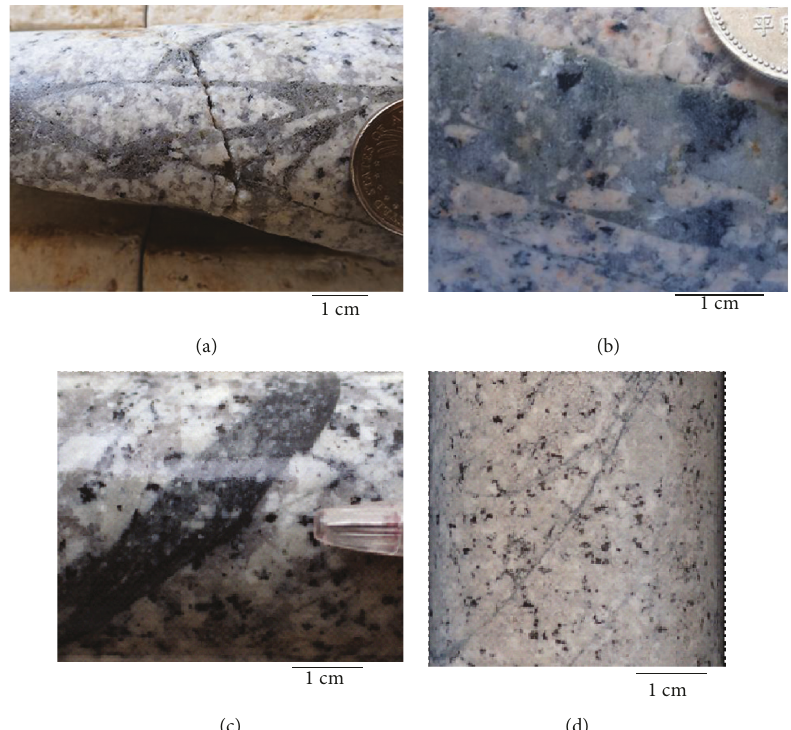
Figure 2: Photographs of rock core samples showing hydrothermal breccia veins in (a) borehole DH-11 and (b) borehole MIZ-1, as well as (c, d) glassy veins in borehole